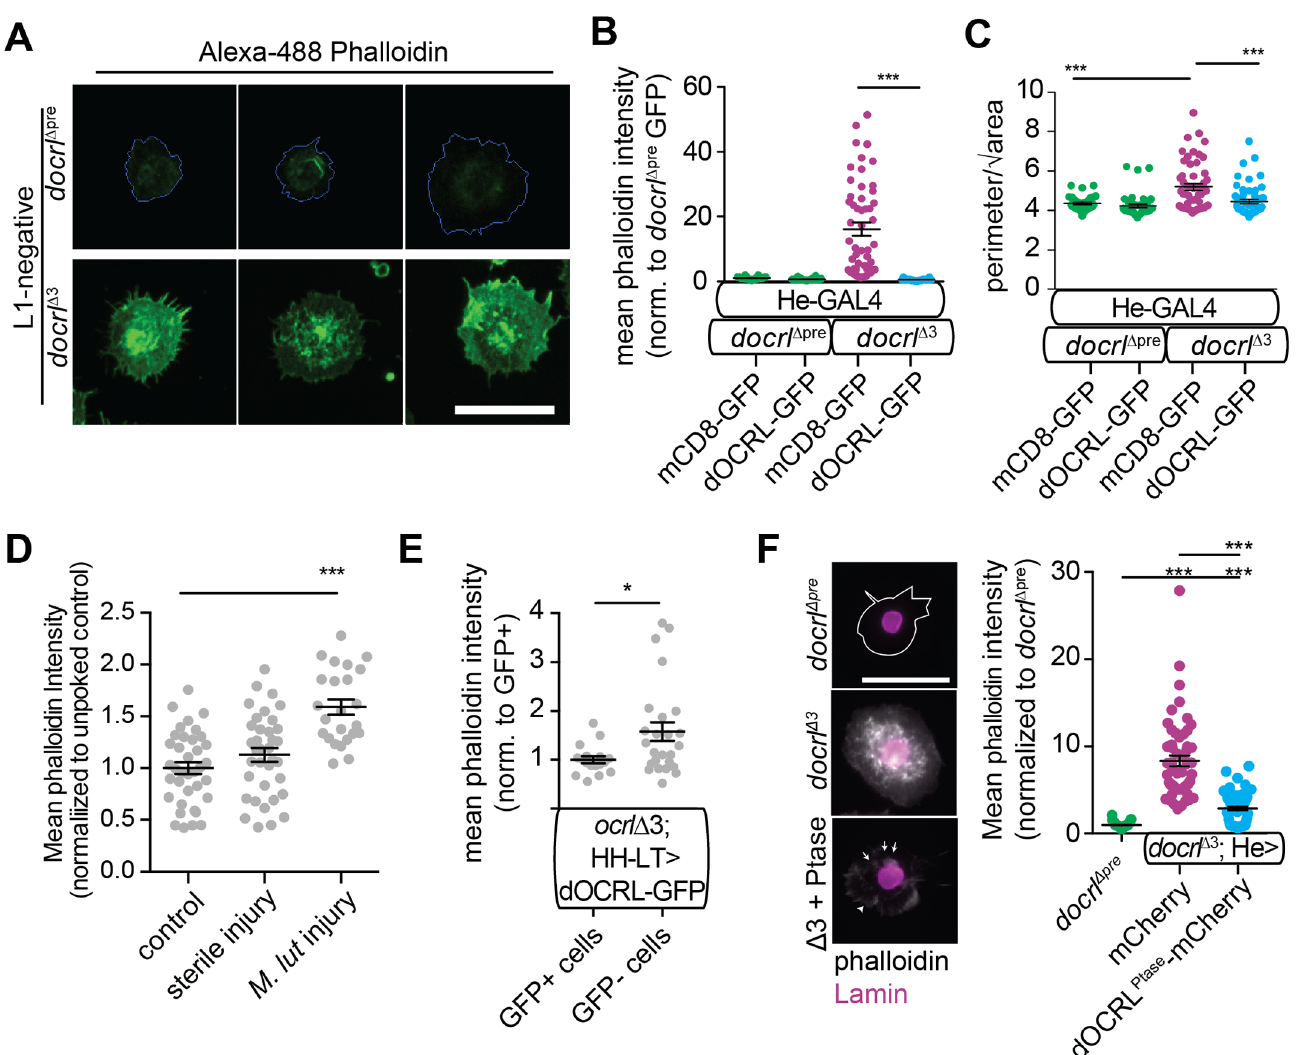
Fig 4. Loss of docrl causesincreased actin assembly in hemocytes. (A) docrl Δ 3 hemocytes exhibitgreater F-actin assembly (phalloidin, green) and a spikier morphology than control cells. (B-C) Quantification of F-actin intensity (B) and ‘spikiness’ (C). Both phenotypes are rescuedby hemocyte- autonomous re-expression of dOCRL-GFP. (D) Infection of larvae with M. luteus promotes assemblyof F-actin in hemocytes. (E) Sparse re- expressionin hemocyteswith HH-LT-GAL4 reducesactin assembly in GFP+ rescue hemocytes, but not GFP- hemocytes that do not express the rescue construct. (F) Expression of phosphatase alone moderately rescues actin accumulation (phalloidinstaining, gray), though actin accumulation at ruffles (arrowhead)and intracellular puncta (arrows) are still observed. Data are presented as mean +/- SEM. Sample N in panelsB-F represent individualcells pooledequallyfrom three independentsamples of 2–4 larvae. Scale bars are 10 μ m.